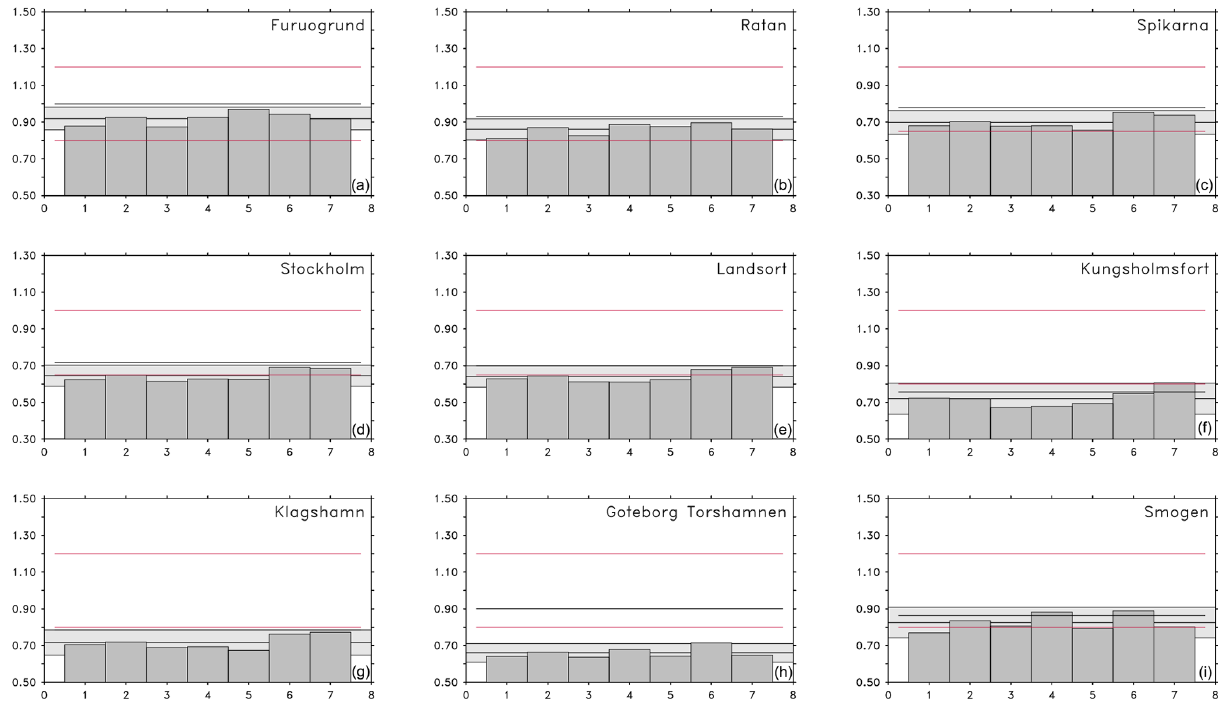
Figure 5. Mean 99.9th percentile of ESLs (m) for the same stations and the same realizations as in Fig. 4. The red lines represent SMHI’s warning level 1 and warning level 2, respectively. The black line is the 99.9th percentile of the observations. All estimates are based on the common historical period of 1970 to 1999.